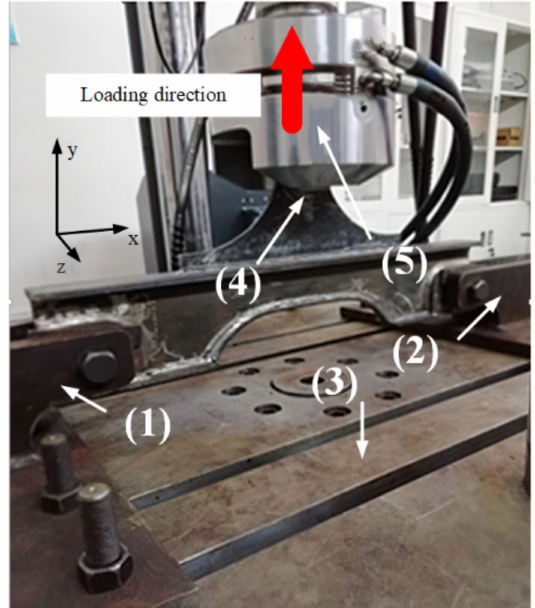
Figure 12. The installation of hatch corner specimen: (1), (2) the ear seats, (3) the test base, (4) the U–shaped chuck, and (5) the fixture of the MTS testing system.